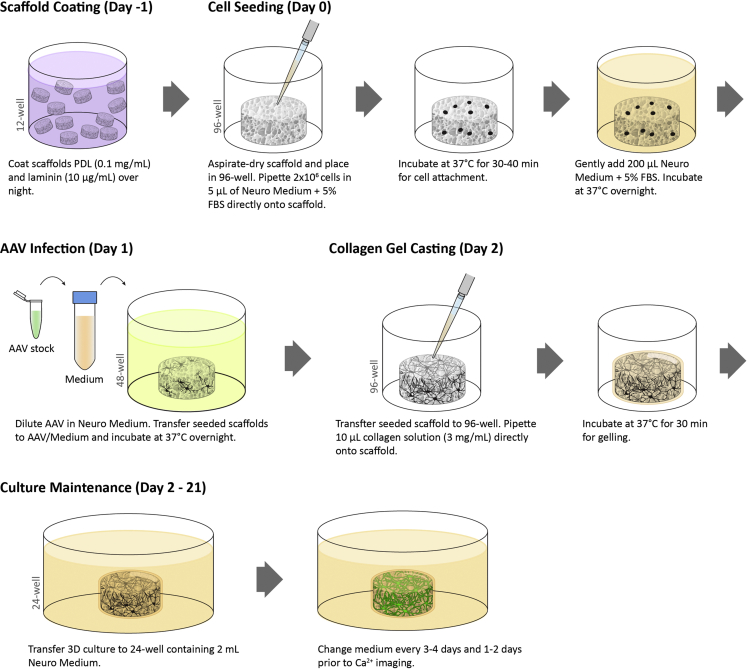
3D GCaMP+ neural culture setup